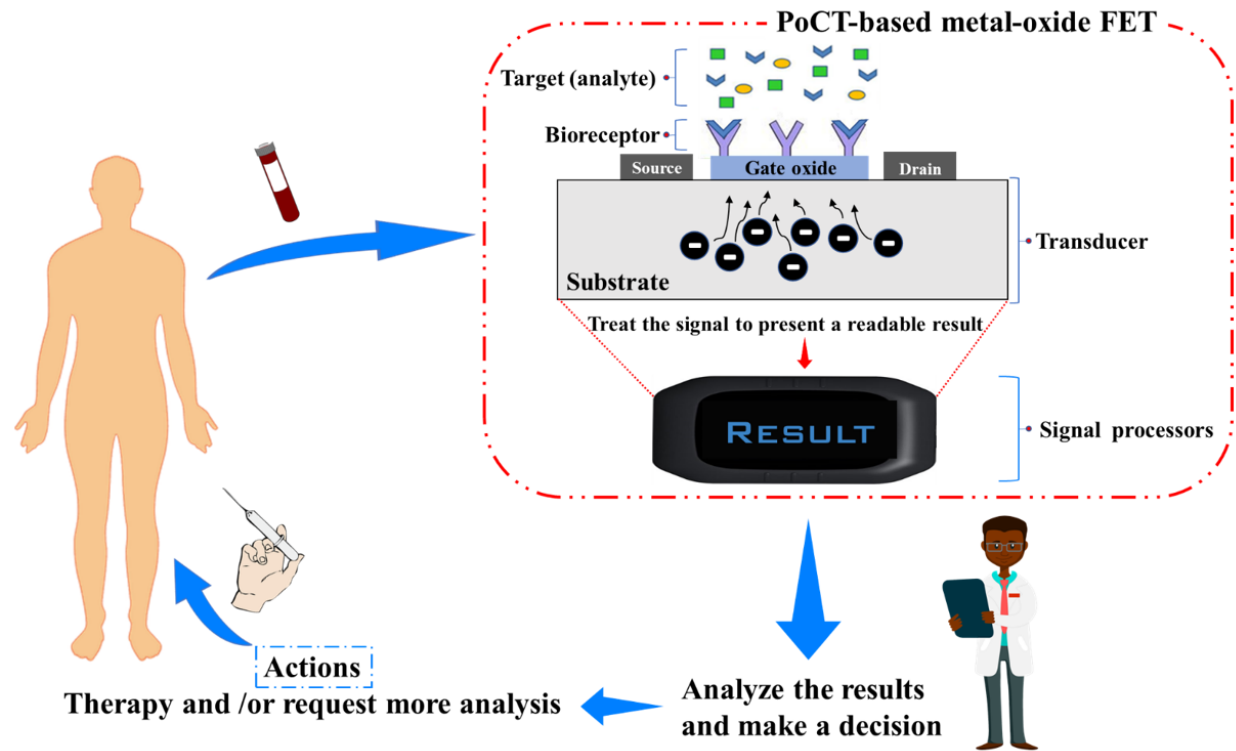
Figure 1. Illustration of a typical PoCT-based metal-oxide field-effect transistor biosensor and its operation process.